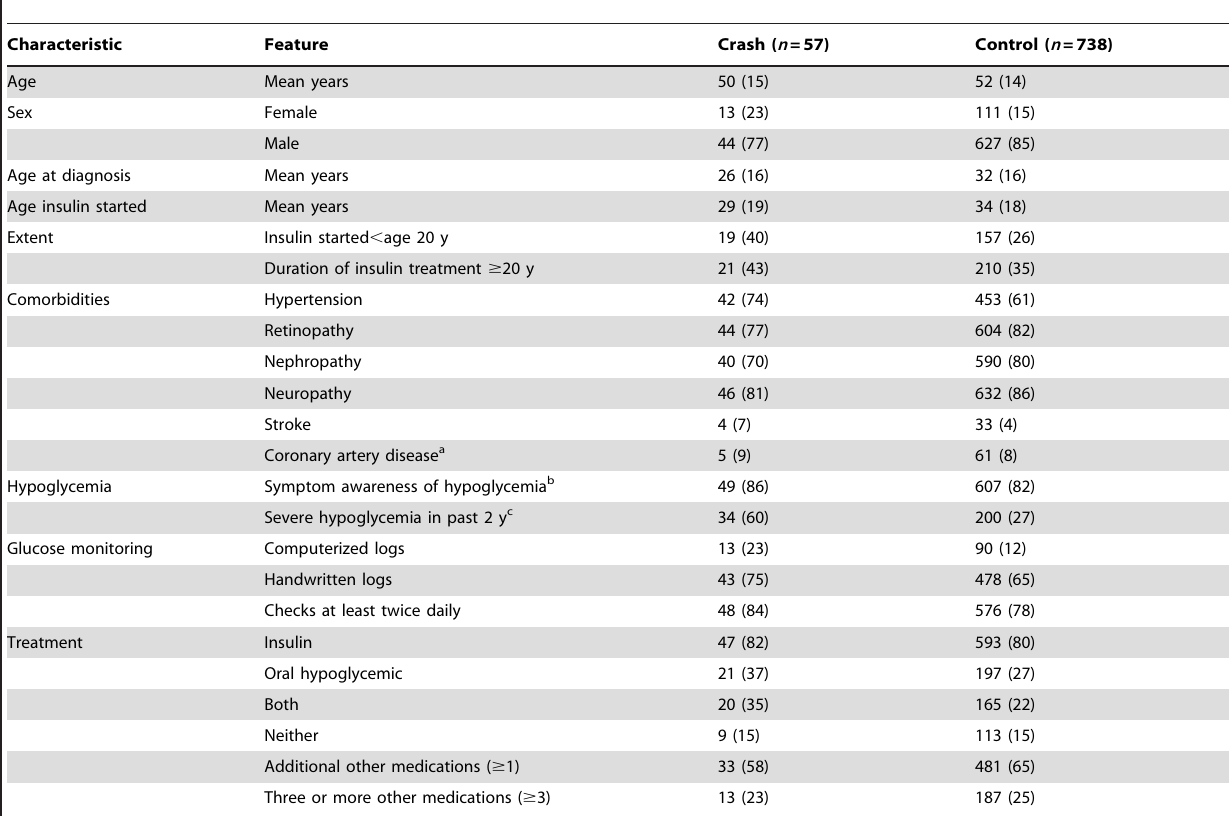
Table 1. Patient